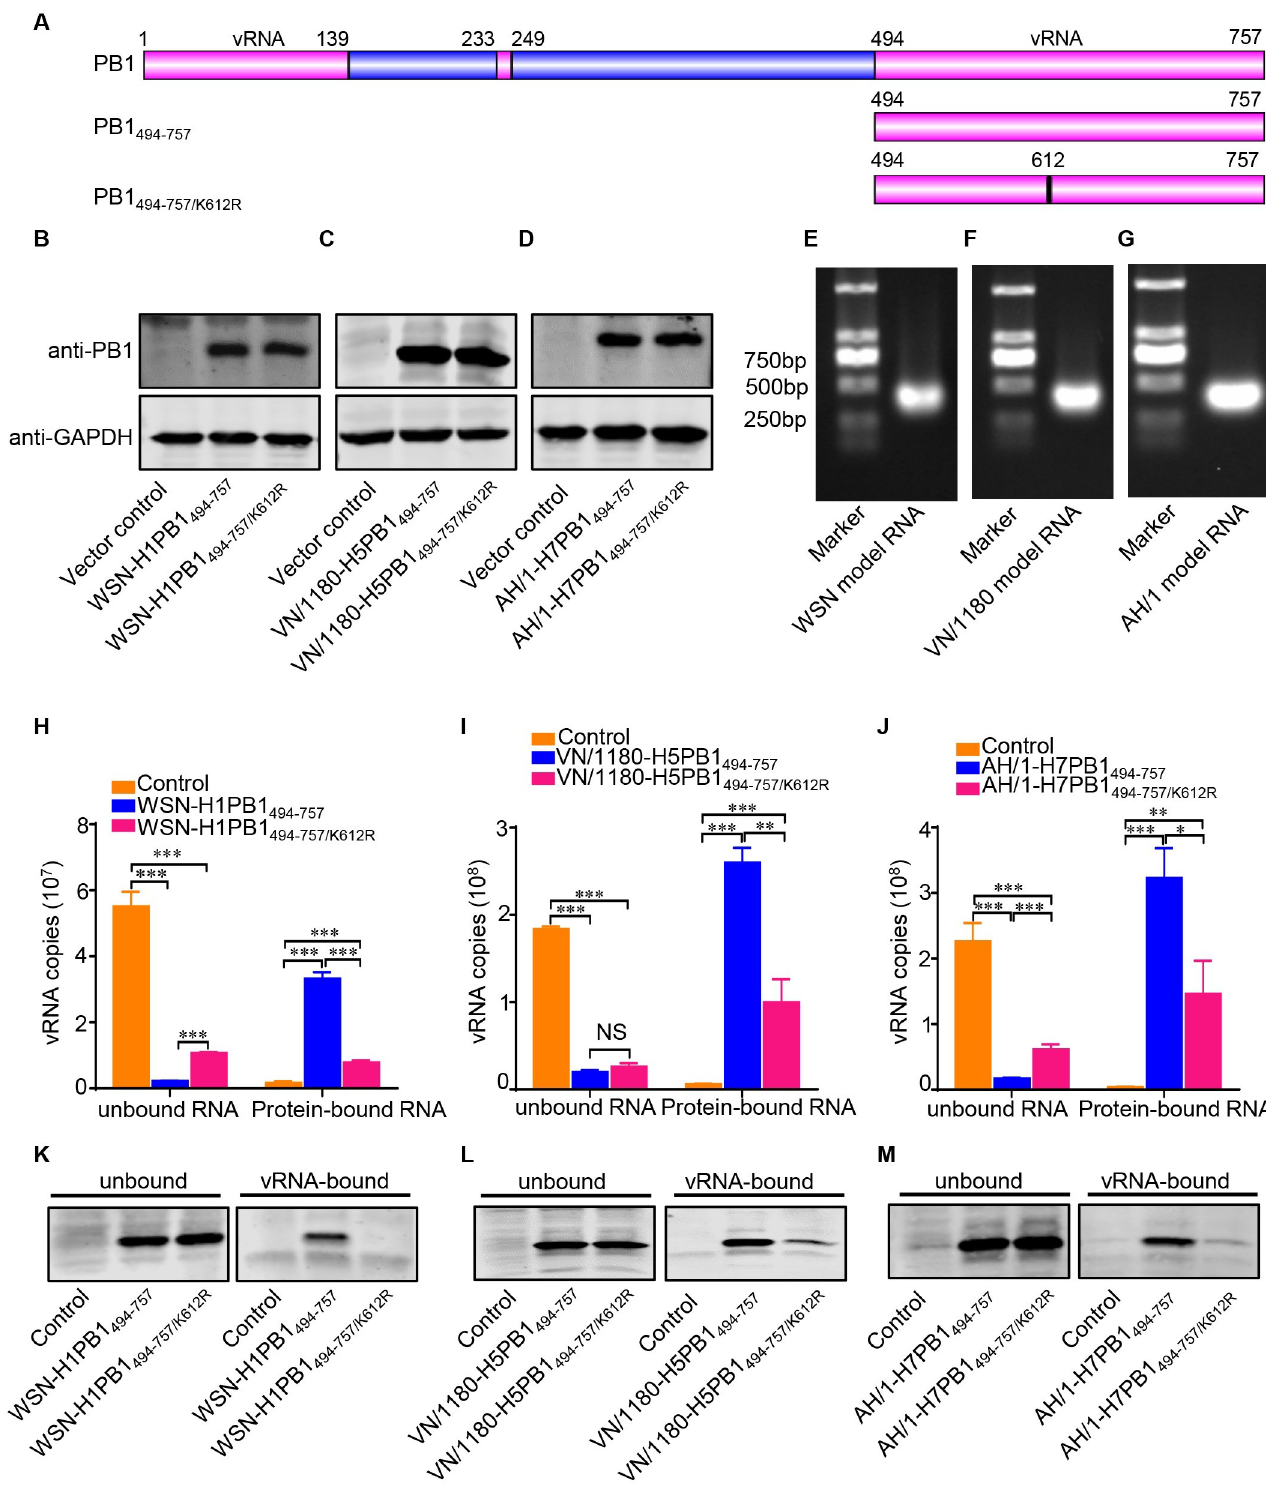
Fig 8. K612R mutation impairs the ability of PB1 to bind to vRNA. (A) Schematic illustration of IAV PB1 and its C-terminal 494–757 region that is involved in the vRNA-binding activity of PB1. The vRNA binding regions in PB1 protein are marked in pink. (B-D) HEK293T cells were transfected with plasmids expressing the Flag-tagged 494–757 region of wild-type PB1 or a K612R mutant PB1 of WSN (H1N1) (B), VN/1180 (H5N1) (C), or AH/1 (H7N9) (D) virus; plasmid expression was verified by western blotting. (E-G) Model vRNAs were transcribed from the NS gene of the WSN (H1N1) (E), VN/1180 (H5N1) (F),